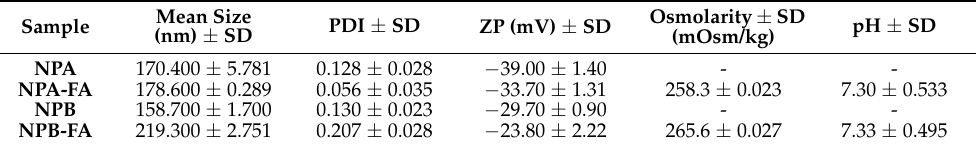
Table 1. Mean size, PDI, zeta potential (ZP), osmolarity and pH of loaded (NPA-FA, NPB-FA)